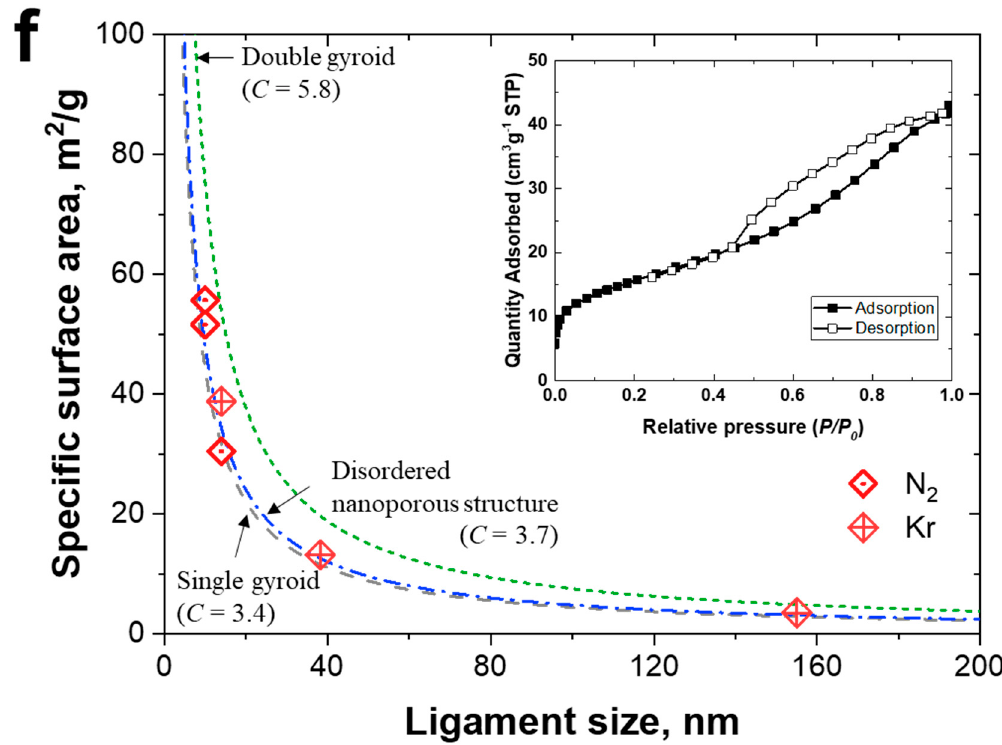
Figure 7. Specific surface areas measured with the Brunauer–Emmett–Teller (BET) method as a function of the ligament size in a TiVNbMoTa nanoporous HEA. The lines (dashed and dashed-dot) correspond to the predictions based on the analytic model S = C / ρ d , as designed and tested in [68]. The inset shows the nitrogen adsorption / desorption curves with an average ligament size of ~10 nm. The solid bulk density ρ was assumed to be 7.7 g · cm − 3 from the average atomic weight and the radius of the constituent elements (Figure reprinted from [55] with permission from Wiley,